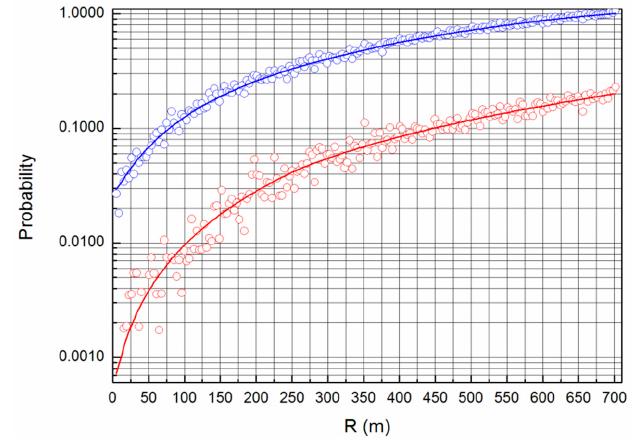
Figure 9. Continuous curves: probability defined by Equation (4), as a function of the radius R of the circle, both for all the catacombs present in the green region of Figure 8 or adjacent to it (blue curve), and for the single Anonymous Hypogeum (red curve). The circles represent the results of the simulations, Equation (5).